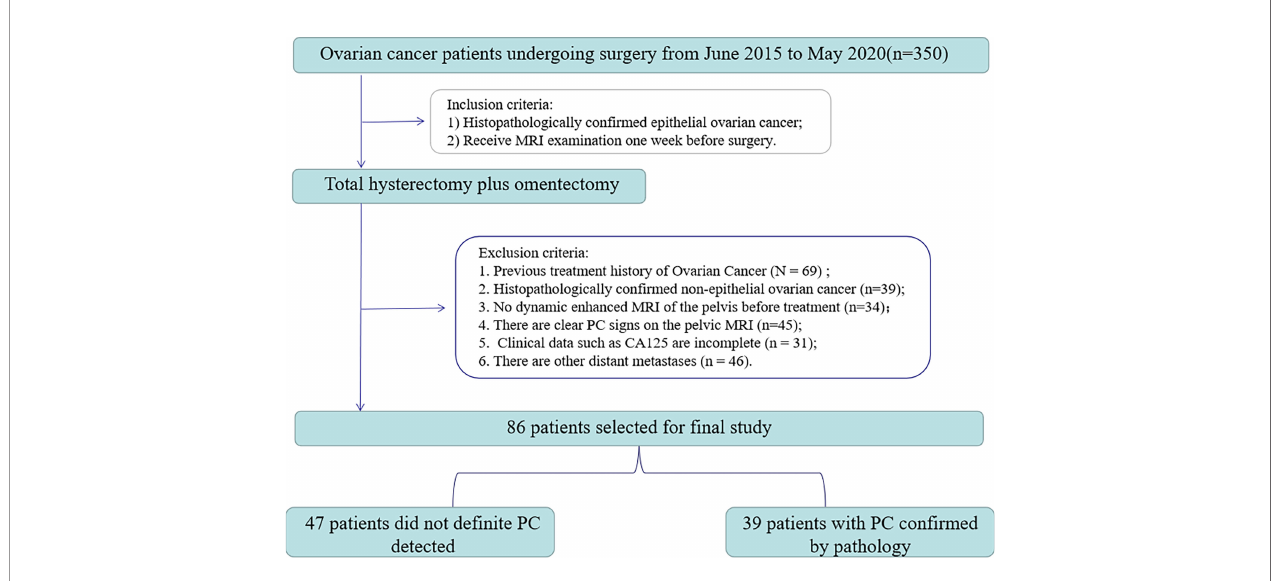
FIGURE 1 | Flowchart of patient